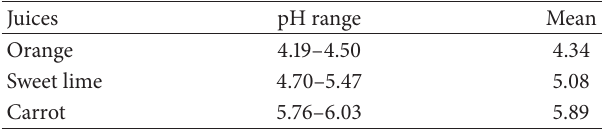
Table 1: pH values of